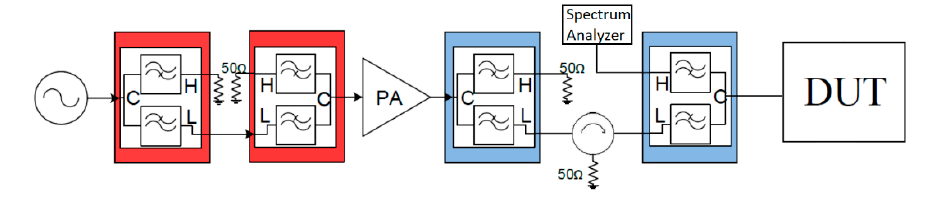
Figure 14. Test setup for harmonic reflection measurement.